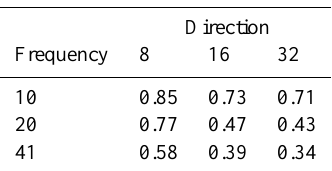
Table 2. SWH RMSE statistics of the various numerical experi- ments performed compared with data collected from the Gagua Ridge buoy.